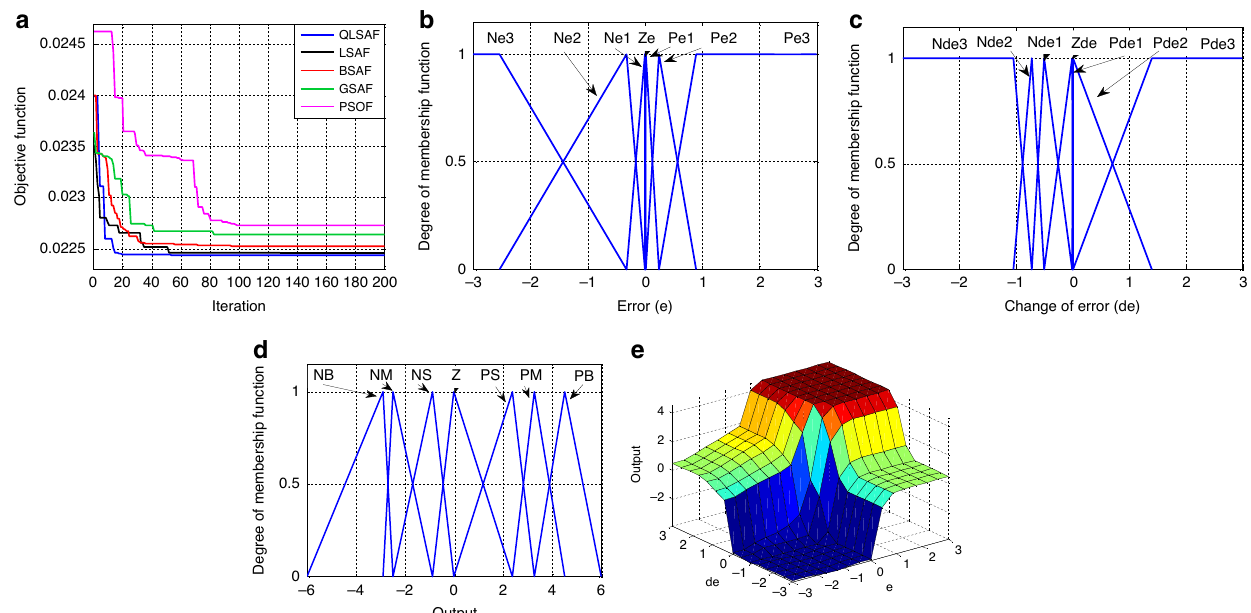
Fig. 3 The optimization results of QLSA. a The objective function assessment results of QLSA, LSA, BSA, GSA and PSO in convergence characteristics curve. b Optimized membership function for error. c Optimized membership function for change of error. d Optimized membership function for output. e Three-dimensional relationship among error, change of error and